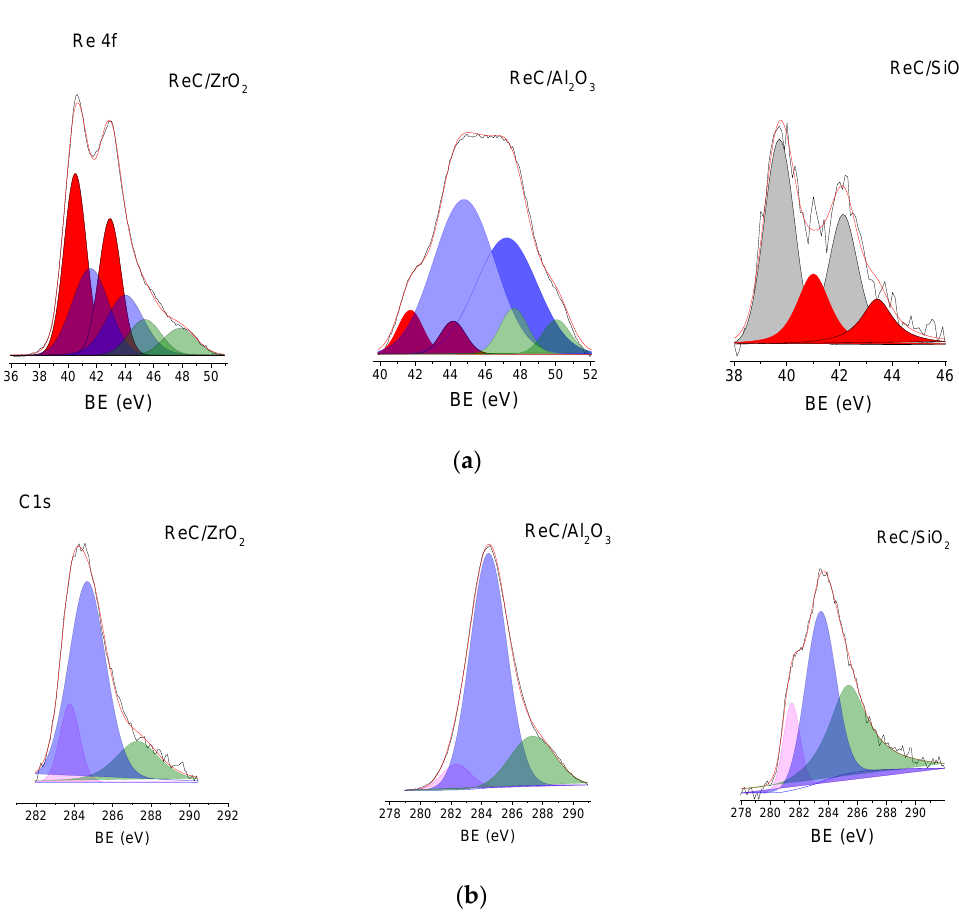
Figure 2. Diffractograms obtained for the catalysts ( a ), zoom in the region from 38° to 48° ( b ). Figure 3 and Table 2 show the surface composition of the catalysts determined by XPS.